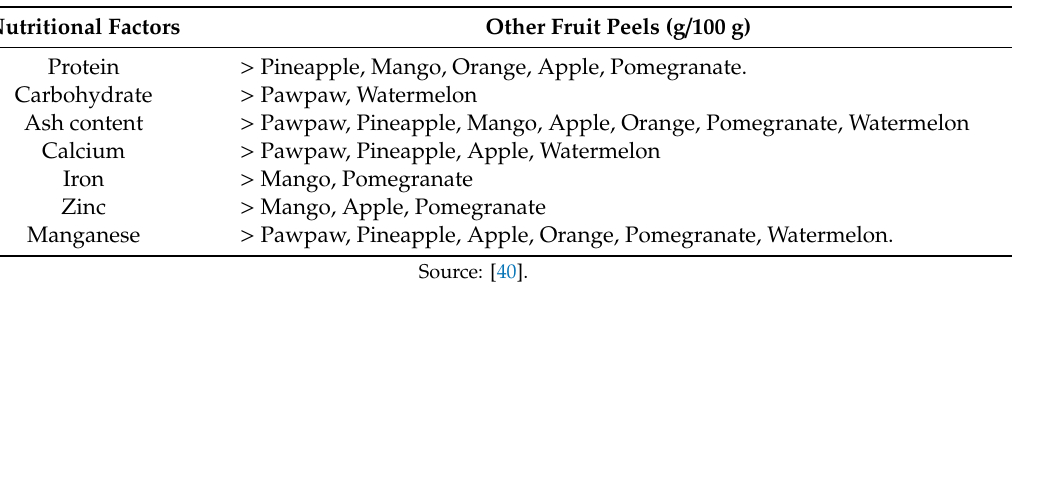
Table 1. Comparative nutritional profile of fruit peels of Musa with other